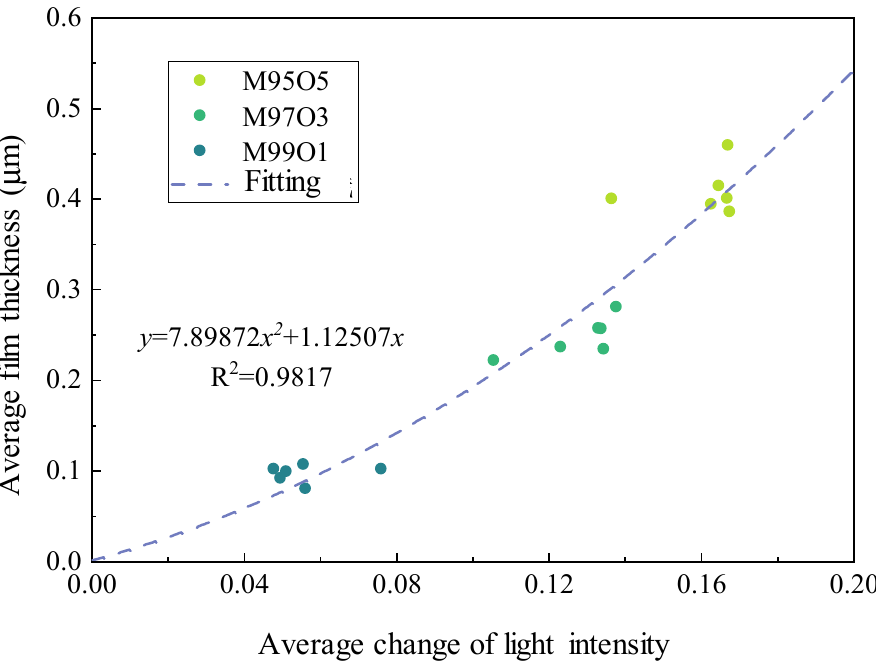
Figure 5. Calibration equation of the fuel film thickness and the average change of light intensity.